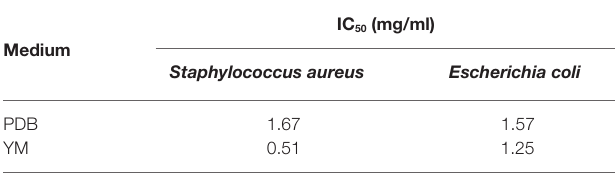
TABLE 4 | IC 50 for ECEs obtained from the co-culture of Xylaria sp. and D. endophytica in different media against the tested